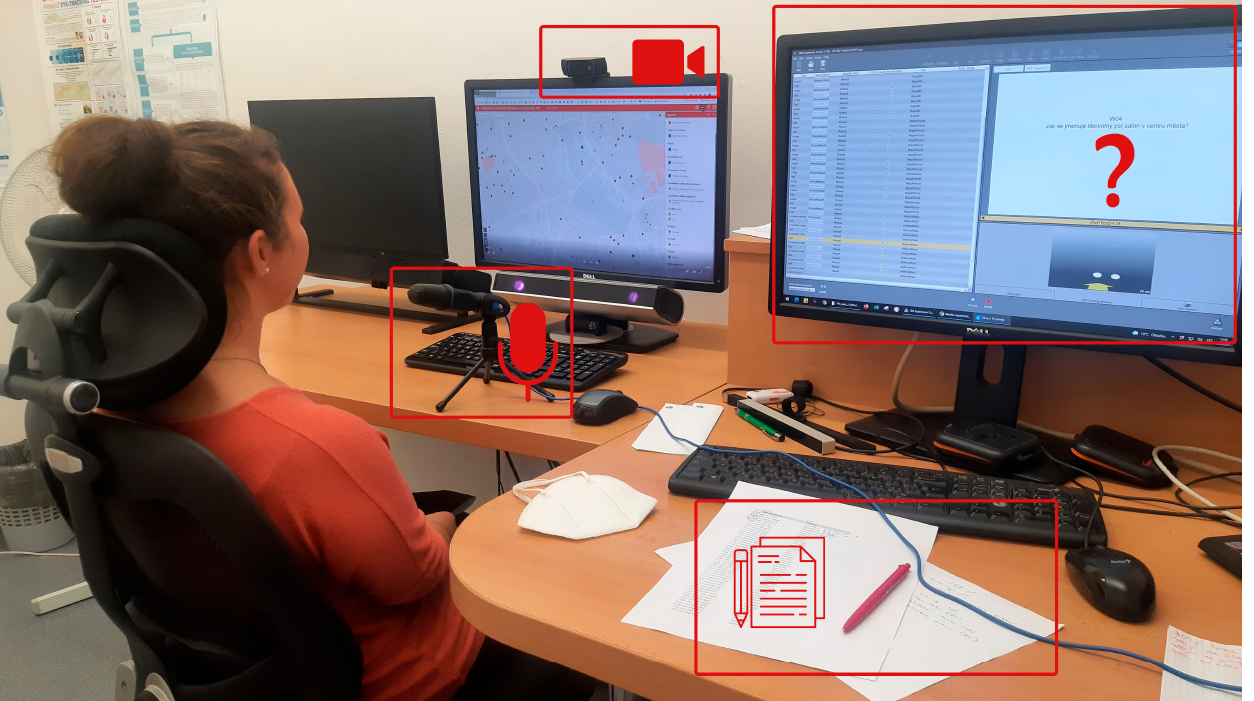
Figure 4. Testing controlled environment in the (pilot) study.